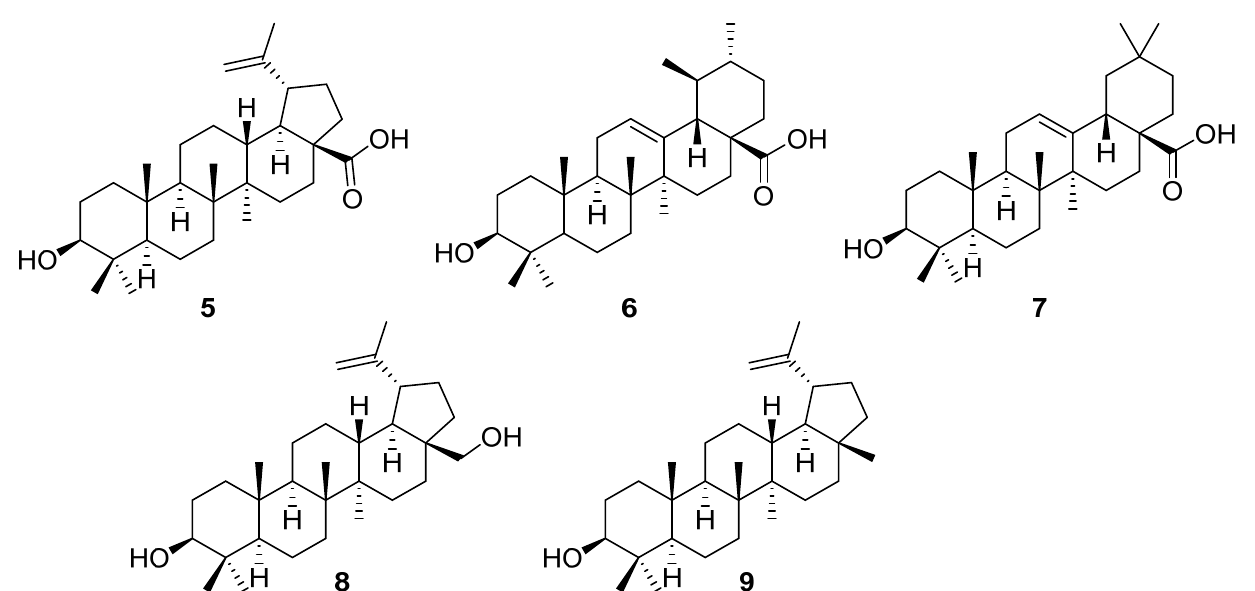
Figure 2. Chemical structures of betulinic acid ( 5 ), ursolic acid ( 6 ), oleanolic acid ( 7 ), betulin ( 8 ), and lupeol ( 9 ).